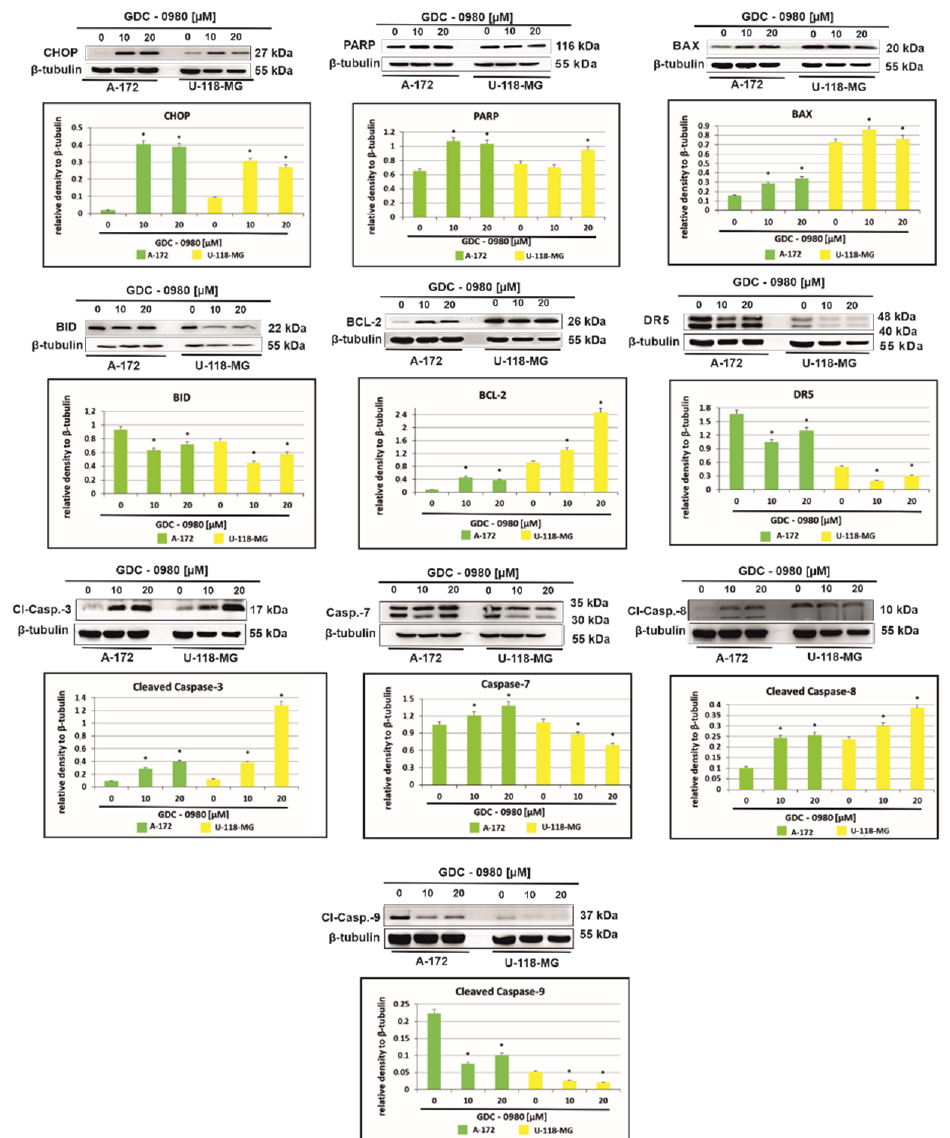
Figure 7. Western blot analysis demonstrates the effect of 48 h GDC-0980 treatment on the expression of CHOP, PARP, BAX, BID, BCL-2, DR5, cleaved caspase-3, caspase-7, cleaved caspase-8, and cleaved caspase-9 in A-172 and U-118 MG glioblastoma cells, using β -tubulin as a protein loading control. The representative bands of the CHOP, PARP, BAX, BID, BCL-2, DR5, cleaved caspase-3, caspase-7, cleaved caspase-8, and cleaved caspase-9 to β -tubulin are illustrated. Samples containing 20 µ g of protein were submitted to electrophoresis and immunoblotting. Data are presented as the means ± SEM. * p < 0.05.